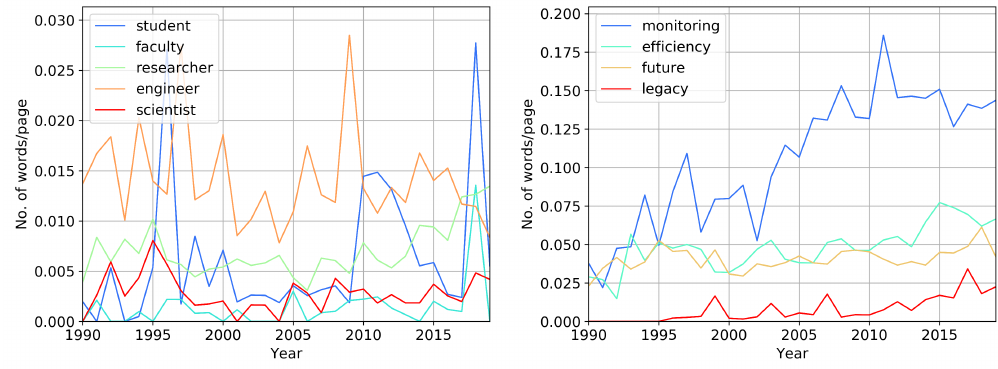
Figure 9. Change in word usage over